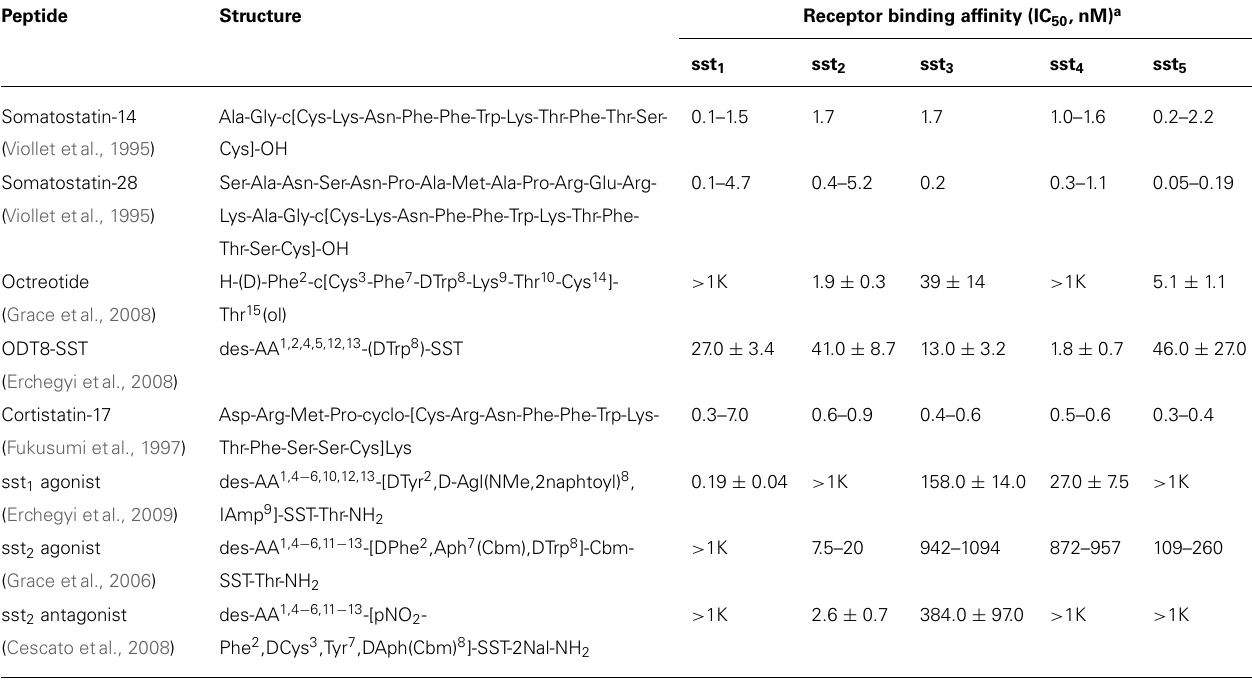
Table 1 | Structure and receptor binding affinity of somatostatin and somatostatin receptor agonists. Peptide